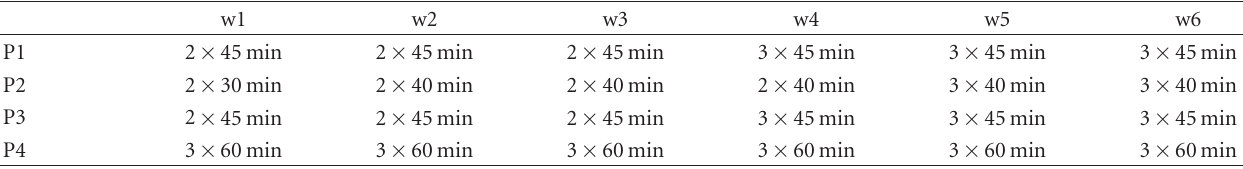
Table 2: Training schedule for each patient from weeks (w) 1 to